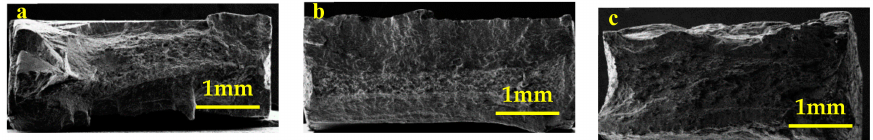
Figure 12. Macroscopic fracture surface of ( a ) 304 stainless steel substrate, ( b ) experimental materials and ( c ) comparative materials.